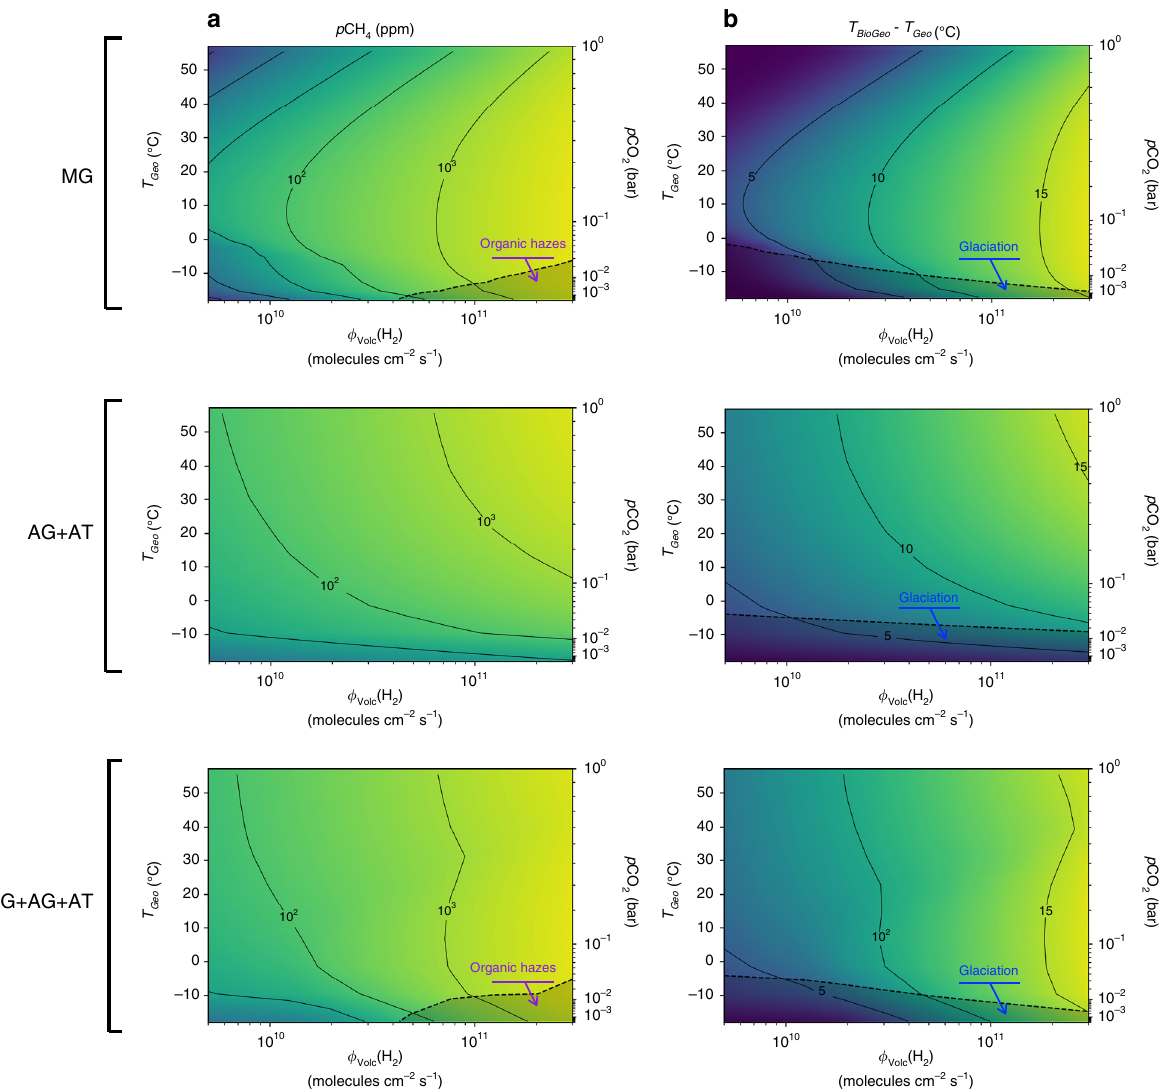
Fig. 3 Short-term biological feedback on the atmosphere and climate. Effects are computed as a function of the H 2 volcanic outgassing and abiotic surface temperature ( T Geo ), for each ecosystem composition. MG indicates H 2 -based methanogens. AG + AT indicates CO-based acetogens and methanogenic acetotrophs consortia. MG + AG + AT indicates co-occurring methanogens, acetogens, and acetotrophs. T Geo is varied by changing p CO 2 in the climate model. a Atmospheric p CH 4 at ecosystem-climate equilibrium. Shaded areas indicate conditions for organic haze formation. b Temperature differential between T Geo and the global surface temperature reached at ecosystem-climate equilibrium, T BioGeo . Shaded areas indicate conditions leading to organic haze formation ( a ) and glaciation ( b ). Other parameters are set at their default values (Supplementary Tables 2 and